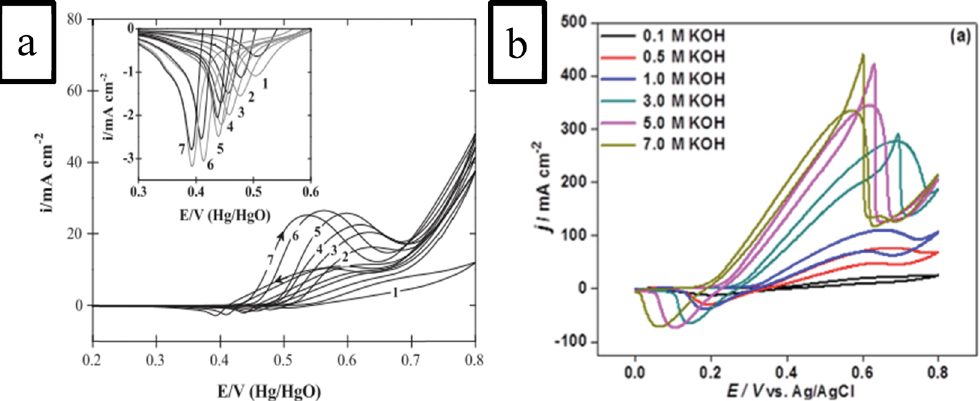
Figure 4: The dependence of urea electro - oxidation on KOH concentrations at ( a ) nickel nanoparticles and ( b ) NiCo/MWCNT electrodes. Scan rates of 10 and 20 mV s − 1 were applied at ( a ) and ( b ) , respectively, republished with permission [ 1,47 ] .